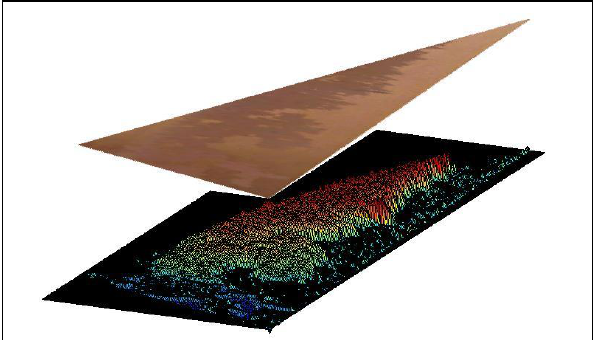
Figure 9. 3D view of image difference of test 2 after radiometric shift and non maxima suppression